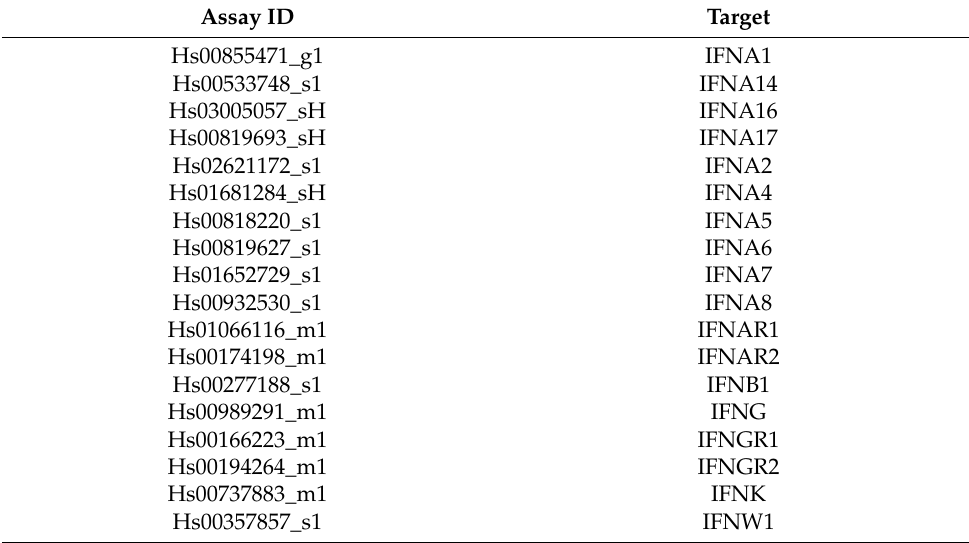
Table 2. Human interferon pathway: Assay IDs and